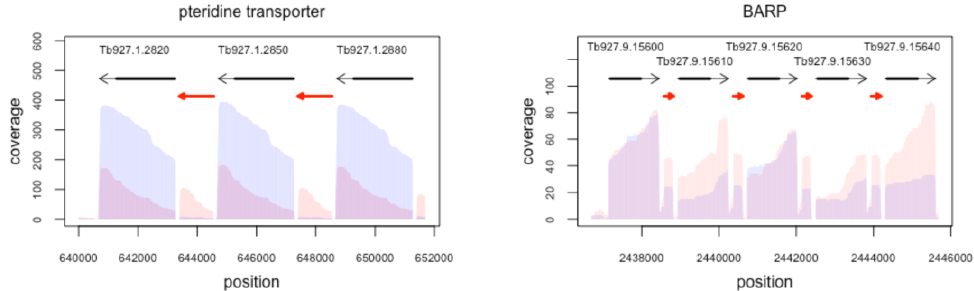
Figure 5. Repetitive lncRNAs. Two examples of genomic regions consisting of repeats of protein- coding genes for identical gene products interrupted by identical lncRNAs. Left: Tandem repeat of pteridine transporter genes on chromosome 1. Right: 3′-domain of the tandem gene array of the bloodstream-alanine-rich protein (BARP) on chromosome 9. Coverage profiles from bloodstream- stage T. brucei are in red. Procyclic-stage profiles are in blue. Grey arrows are annotated exons with coding sequences as thick black lines. Red arrows are lncRNAs.